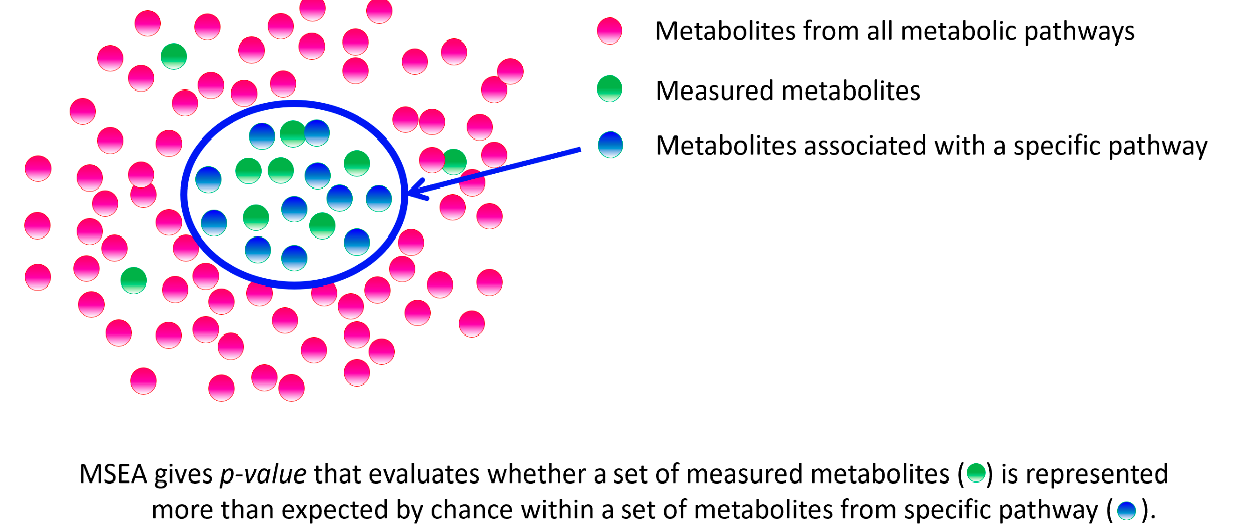
Figure 1. Principle of metabolite set enrichment analysis (MSEA).